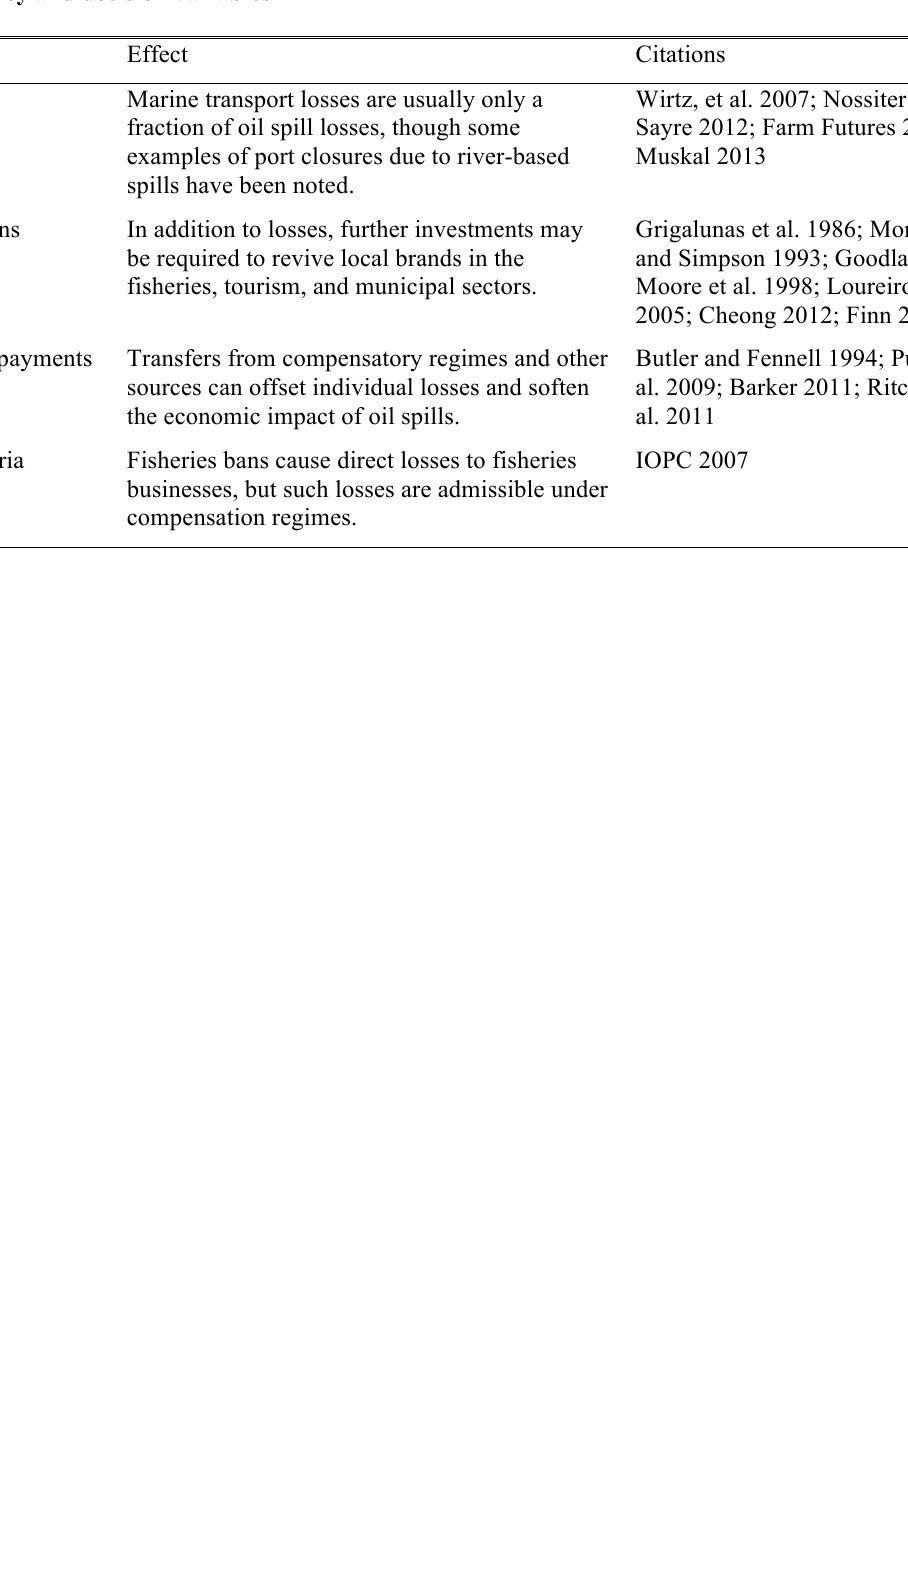
Table A1.7 Policy and decision